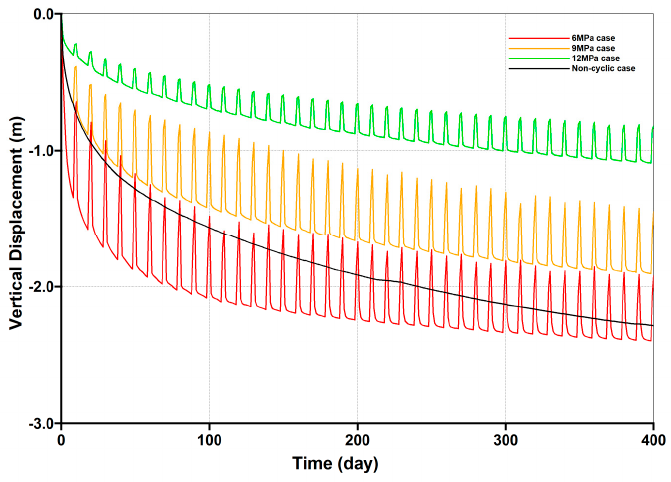
Figure 10. Results of vertical displacement by use of different bottomhole pressure during primary depressurization stage.